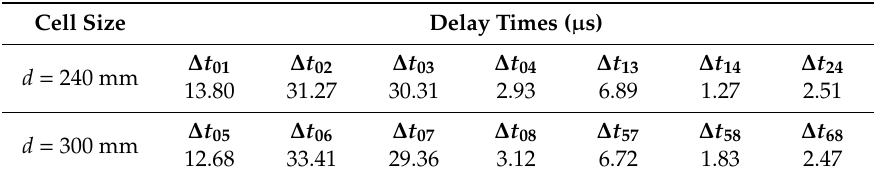
Table 4. Delay times ( µ s) calculated through experiments.